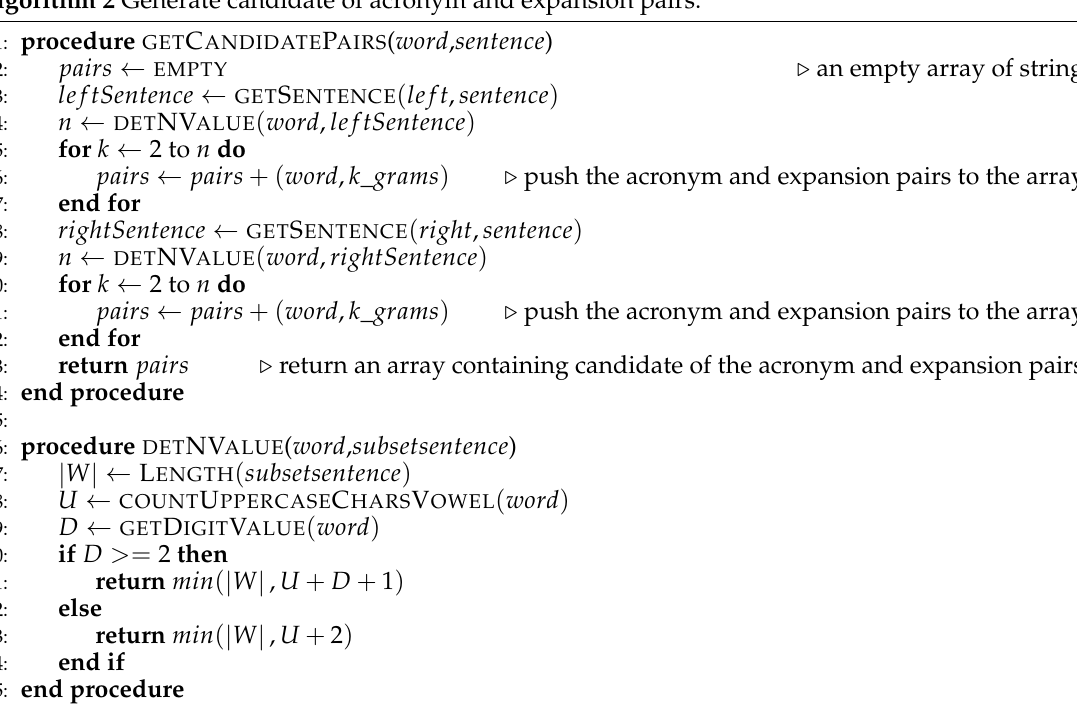
Algorithm 2 Generate candidate of acronym and expansion